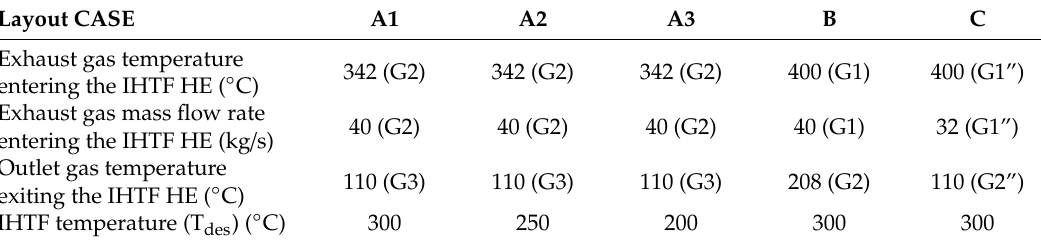
Table 4. ORC layouts dependent